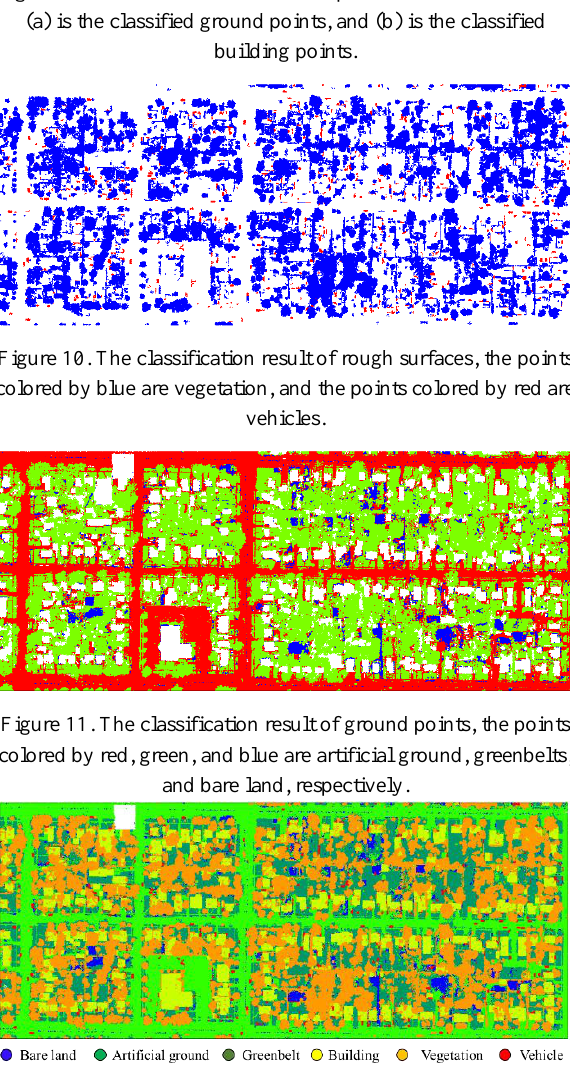
Figure 12. The classification result of the whole testing data. From the aspect of different classes, the -score of class greenbelt (0.959) is higher than the other classes. The reason is that the RGB information of greenbelt is different with those of bare land and artificial ground which contributes to the accuracy value most. In contrast, the -scores of bare land and artificial ground are relatively low due the fact that the RGB information of most majority of bare lands is similar to artificial ground. For the class building, the most serious problem is that the building elements such as chimneys are often mislabeled as vegetation. However, the problem does not affect the